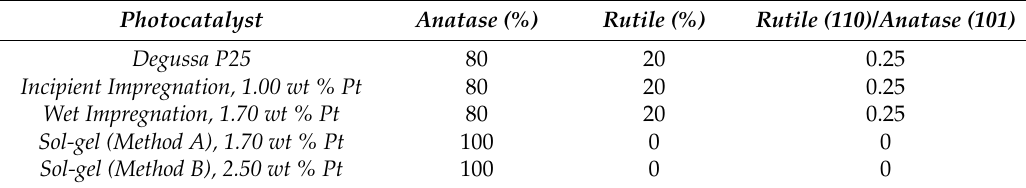
Figure 8. X-ray diffractogram for: ( A ) TiO 2 , Degussa P25; ( B ) wet impregnated with 1.70 wt % Pt on TiO 2 Degussa P25; ( C ) incipiently impregnated with 1.00 wt % Pt on TiO 2 Degussa P25. Table 3. Relative composition of rutile and anatase in the prepared photocatalysts as assessed using the 25° Bragg angle and the 27° Bragg angle bands in the 2 θ scale.